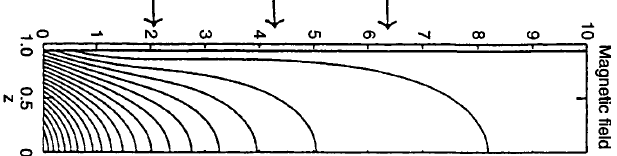
Fig. 3. 2-dimensional simulation of current sheet formation. Unperturbated magnetic field of the near-Earth plasma sheet at t (cid:136) 0. Boundary perturbations due to localized inflow through the plasma sheet boundary at z (cid:136) 1 are switched on near x E (cid:136) 2 : 1 (case 1), x E (cid:136) 4 : 2 (case 2) and x E (cid:136) 6 : 3